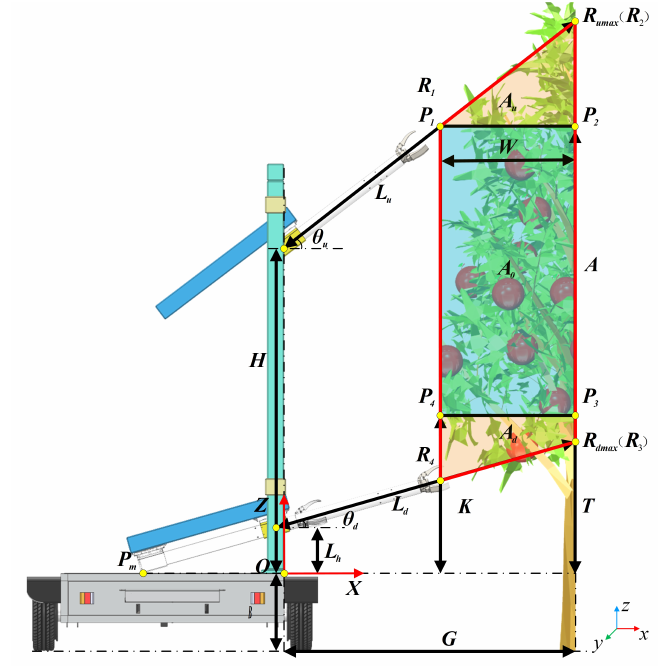
Figure 4. Dual-manipulator simplified configuration